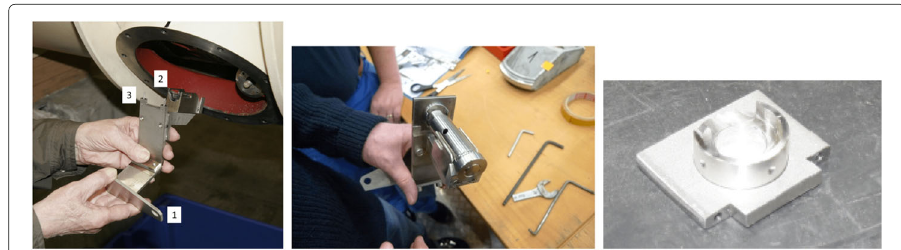
Fig. 17 Tool for proper placing of the outer pressure props. Left: 1: Plate to fasten the tool to the flange of the vacuum vessel, 2: Cradle to hold the pressure prop, 3: Pins to connect to the outer pressure plate. Middle: Complete prop in the assembly tool. Right: Outer pressure plate with support